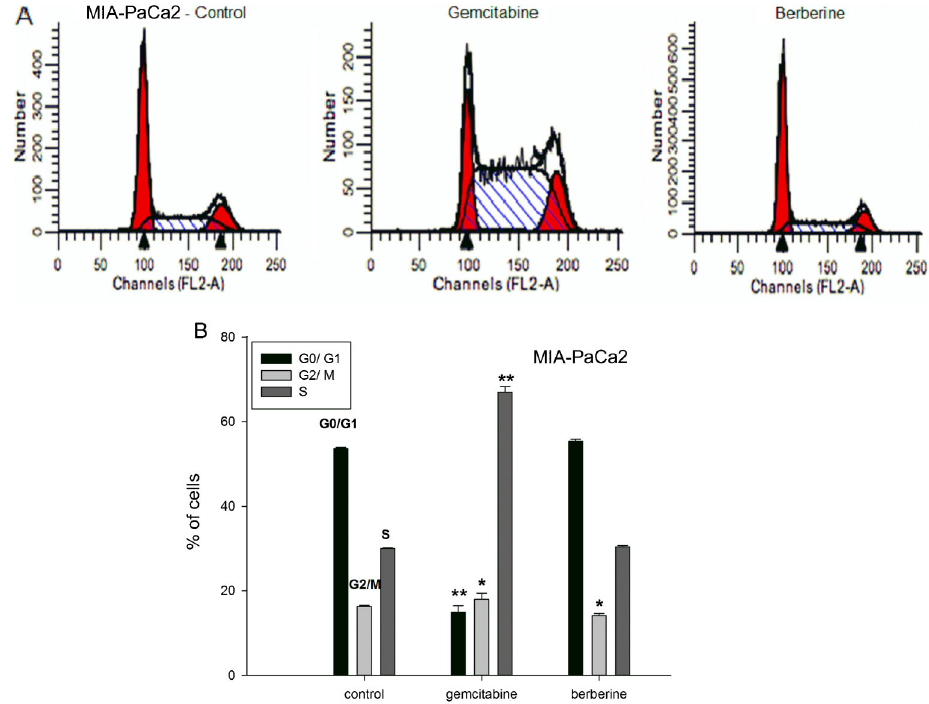
Figure 3. Cell cycle after treatment of MIA-PaCa2 with berberine or gemcitabine. MIA-PaCa2 cells were treated with distilled water (control), 10 m M berberine, or 7 nM gemcitabine for 72 h. The cell cycle distribution was analyzed by the ModFit LT software and depicted using histograms ( A ) and bar plots ( B ). Cell cycle was analyzed as the percentage of cells at each stage of the cell cycle after DNA staining with PI. Data from a representative experiment (from a total of at least three) are shown. *P , 0.05, **P , 0.01 versus control (Student’s t